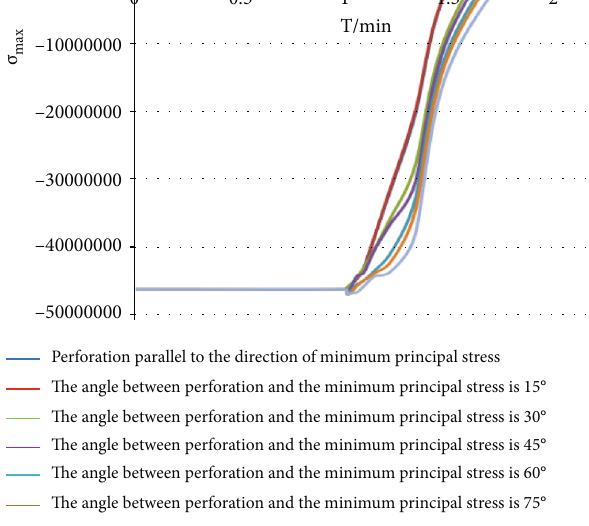
Figure 10: Curves of maximum principal stress changing with time in front of perforation at di ff erent